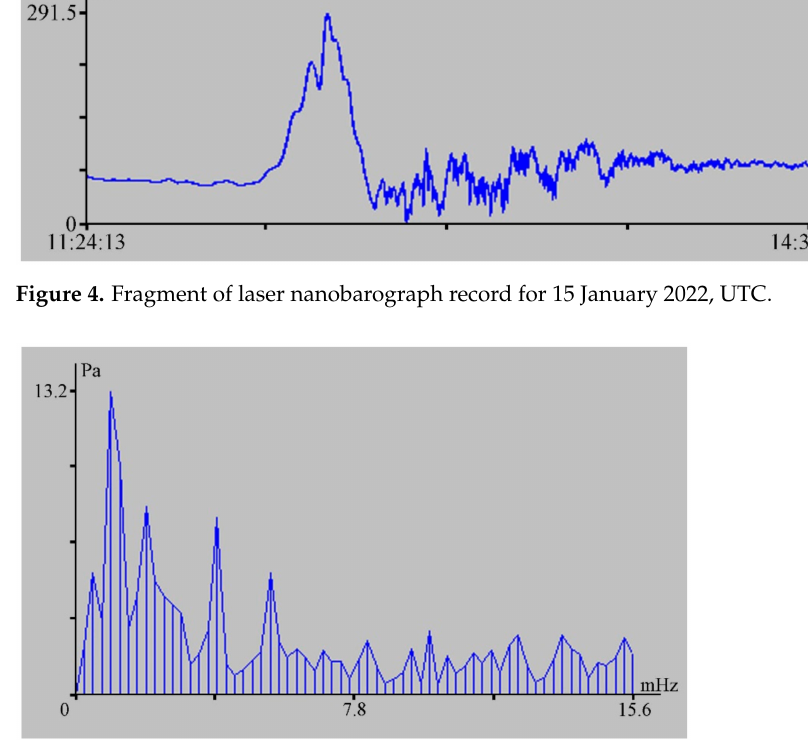
Figure 5. Spectrum of laser nanobarograph record fragment with duration of 4096 s. The atmospheric pressure impulse and acoustic-gravity Lamb waves caused deforma- tions of a similar type in the Earth’s crust (see Figures 6 and 7). In the figures, an impulse in the Earth’s crust caused by the acoustic-gravity Lamb wave is highlighted in red, and 4096 seconds after the pulse is highlighted in green; these were further analyzed.